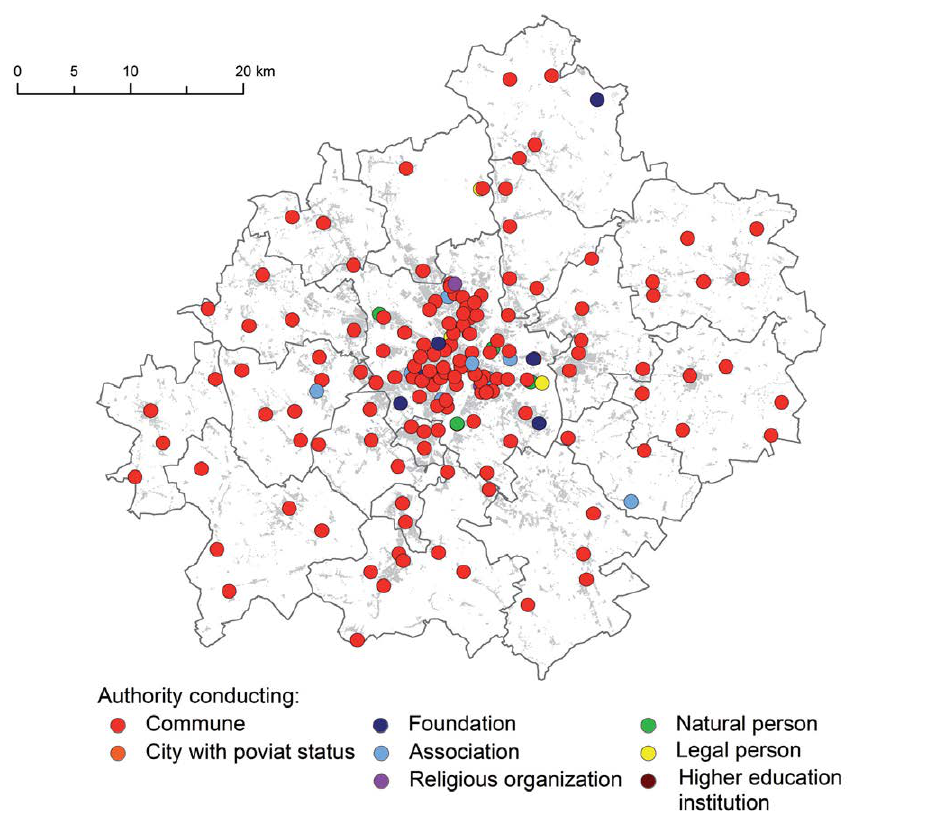
Fig. 4. spatial distribution of primary schools in the Poznań agglomeration (2014). Source: own